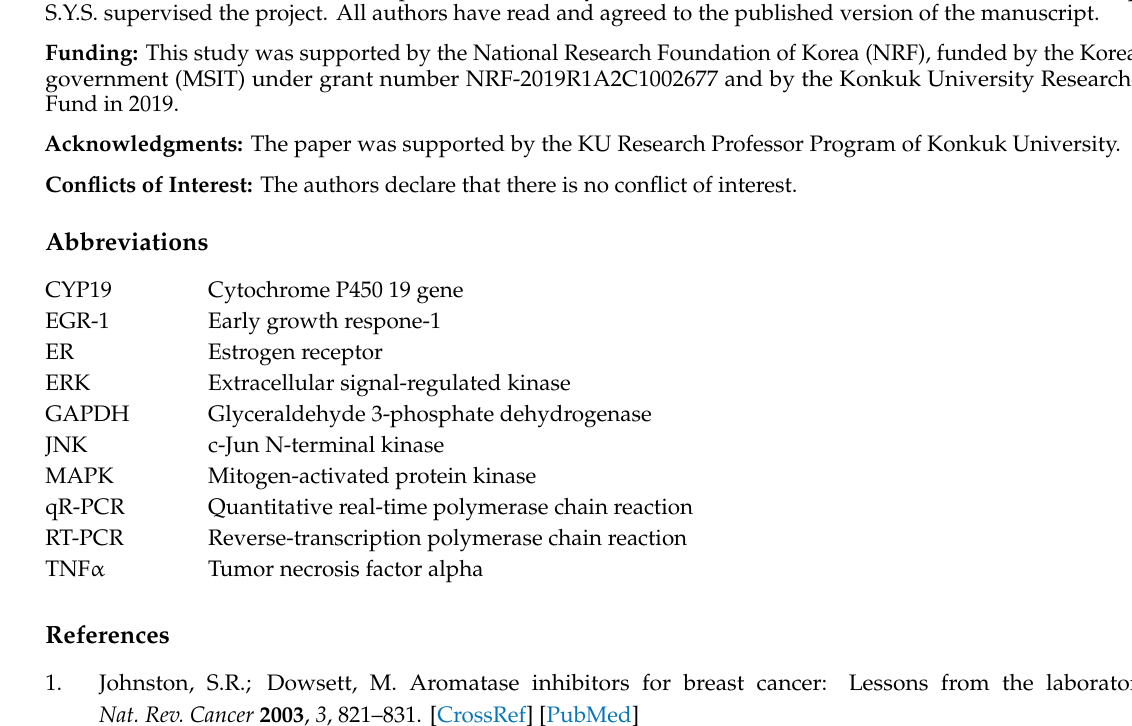
Table S1: Inhibitory e ff ects of flavonoids on TNF α -induced EGR1 promoter